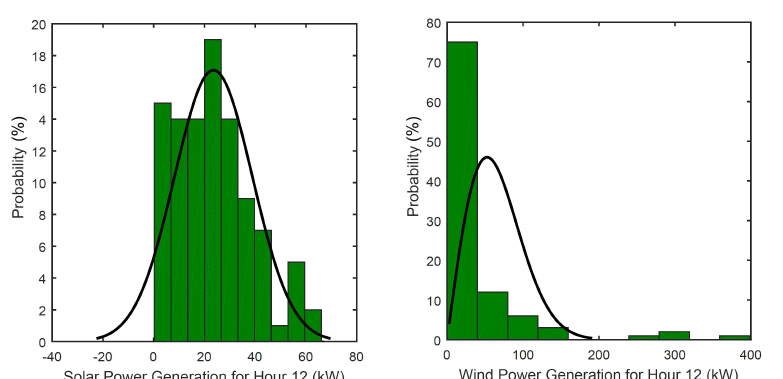
Figure 16. Probability of the power generation from solar PV ( left ) and wind ( right ) at the 12th hour on the 21 December case study.